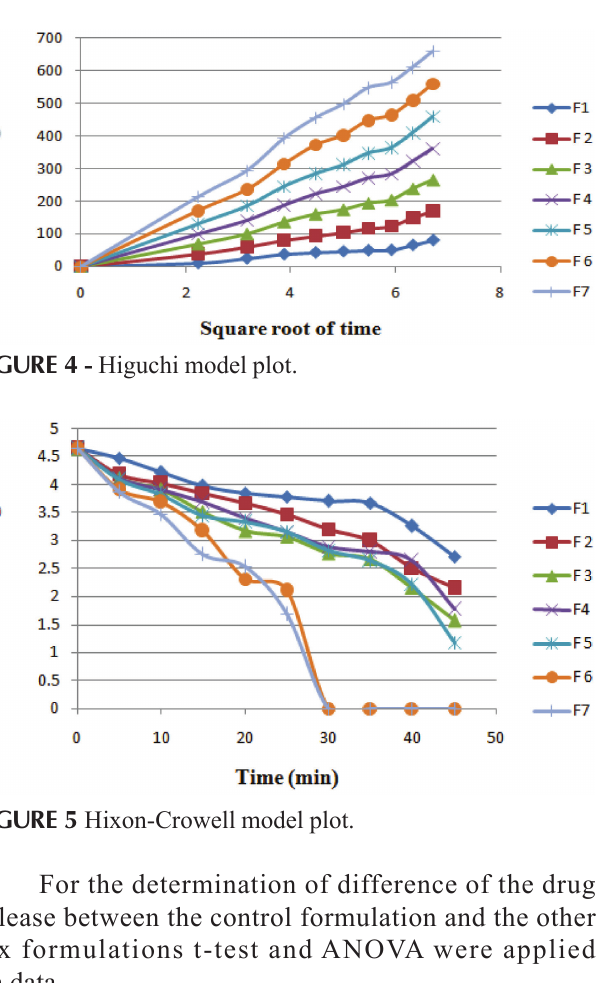
TABLE V - Results of one way ANOVA